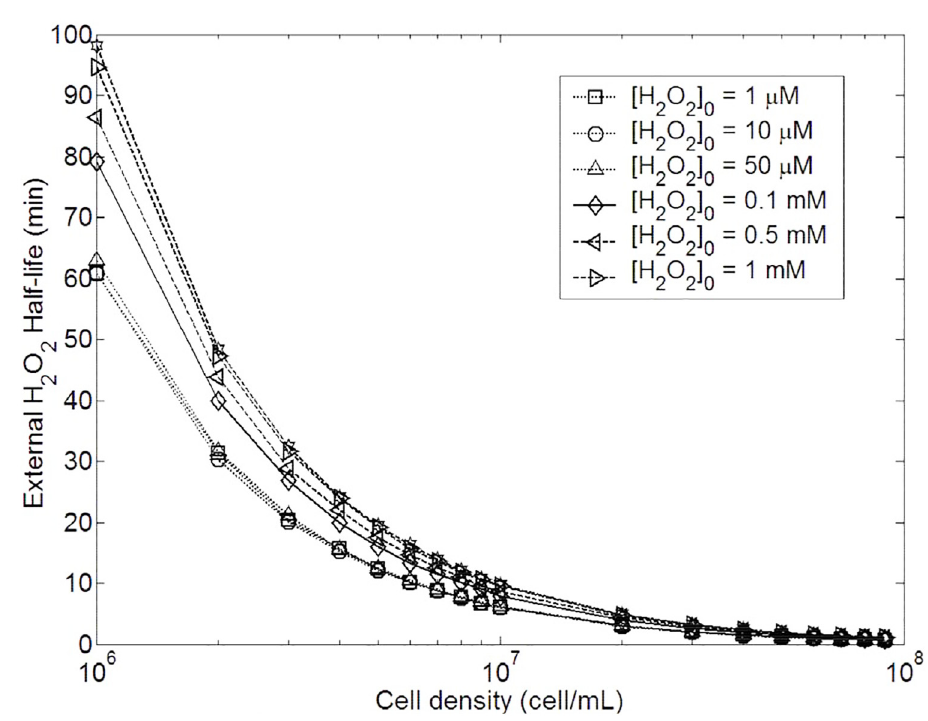
Fig 13. Changes in external H 2 O 2 half-life with cell densities and with 7 different initial external H 2 O 2 concentrations in E. coli wild type. The numerical solution presented in this graph was running according to the whole model without